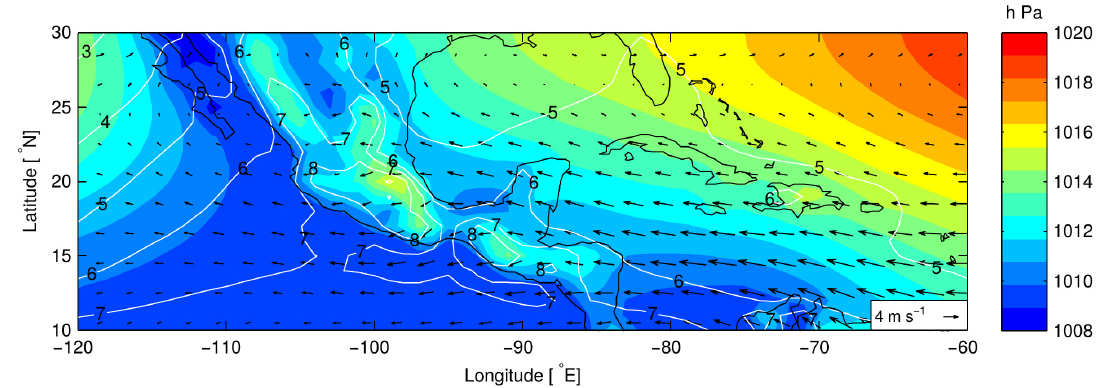
Figure 1. Study area with the long-term seasonal climatology of mean sea level pressure (shaded, in hPa), 700 hPa winds (vectors, in m s − 1 ), and 700 hPa specific humidity (isolines, in g kg − 1 ), from